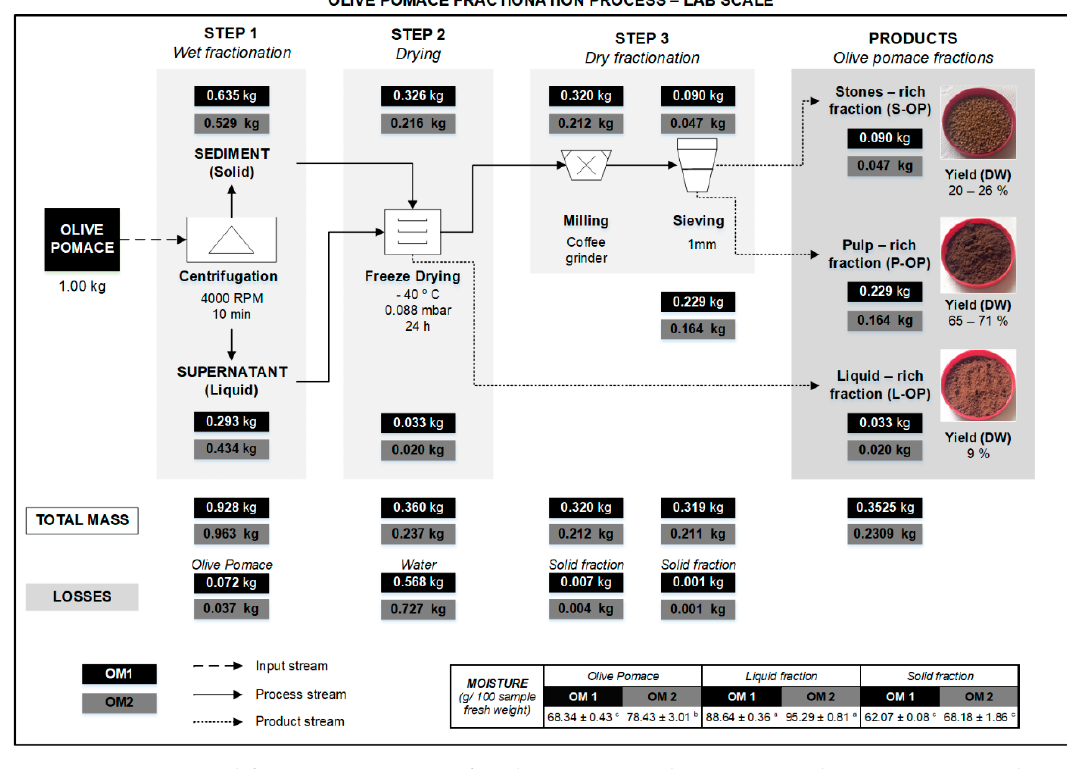
Figure 1. Proposed fractionation process for olive pomace valorisation to achieve maximum value and “zero waste”: products and yields. Abbreviations: OM 1—olive mill 1, OM 2—olive mill 2, C-